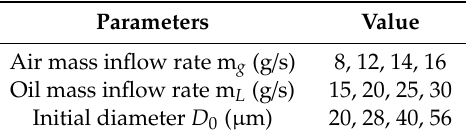
Table 1. Operating Table 1. Operating condition.